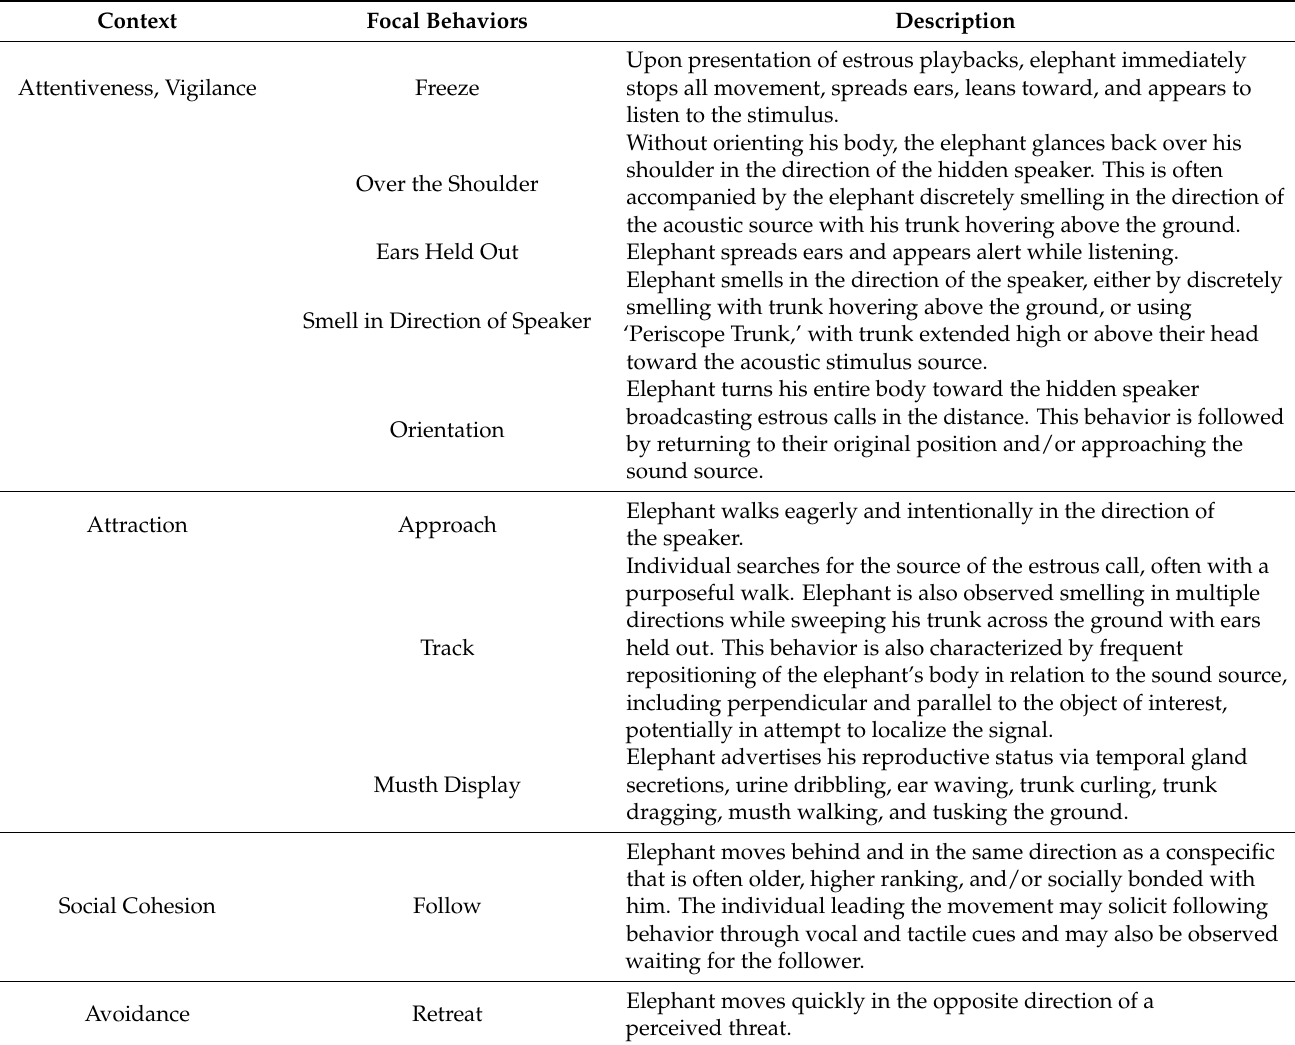
Table 2. Ethogram of focal behaviors observed in male elephants ( n = 19) during estrous playback experiments. Response score criteria, set on a gradient scale from 0 to 1, were based both on the occurrence and frequency of these behaviors. In the case that certain behaviors were observed in different contexts, both are listed, (e.g., attentiveness and vigilance). In addition, elephants who did not display any of these behaviors in response to playbacks and continued along their movement trajectory were given a score of 0. Further details on the application of these behaviors to response score criteria can be found in Figure